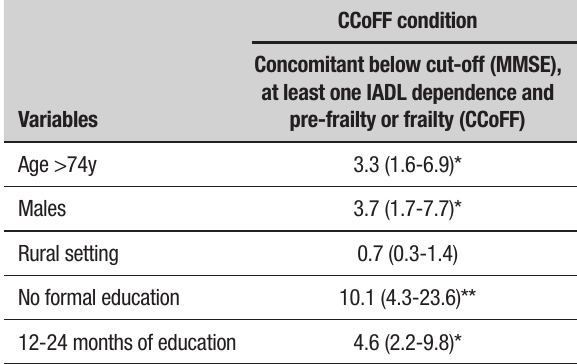
Table 5. Factors (age, sex, setting and level of formal education) associated with CCoFF status. Odds ratio, 95% confidence intervals in